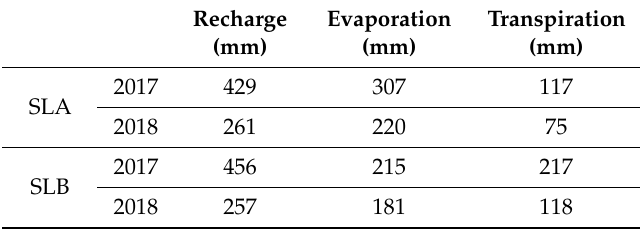
Table 5. Annual simulated groundwater recharge, evaporation, and transpiration values for sites SLA and SLB. Recharge Evaporation